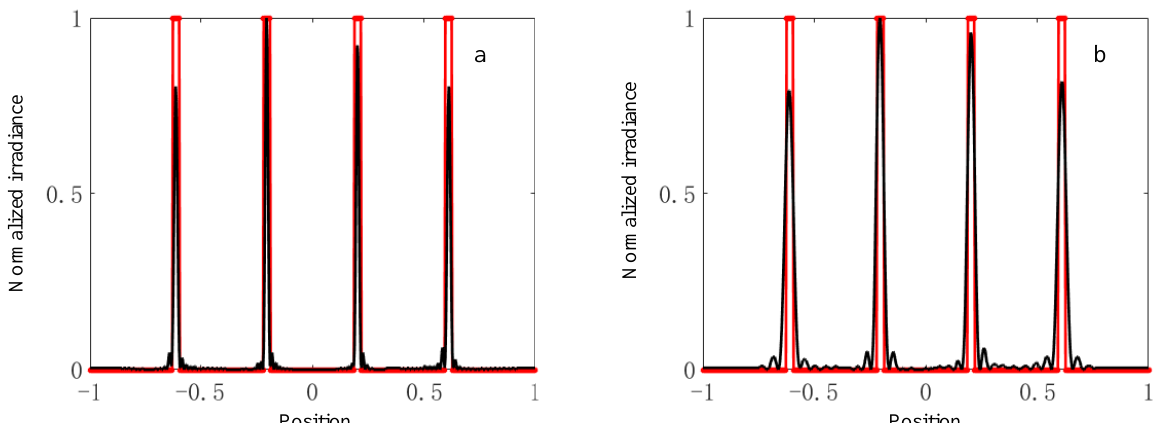
Figure 4. Comparison of the simulated (black line) and target irradiance (red line) of the diffraction in-tensity distribution of the rectangular expansion mask (line 320th in the horizontal direction of diffraction pattern) where ( a ) f = 2 cm and ( b ) f = 5 cm.